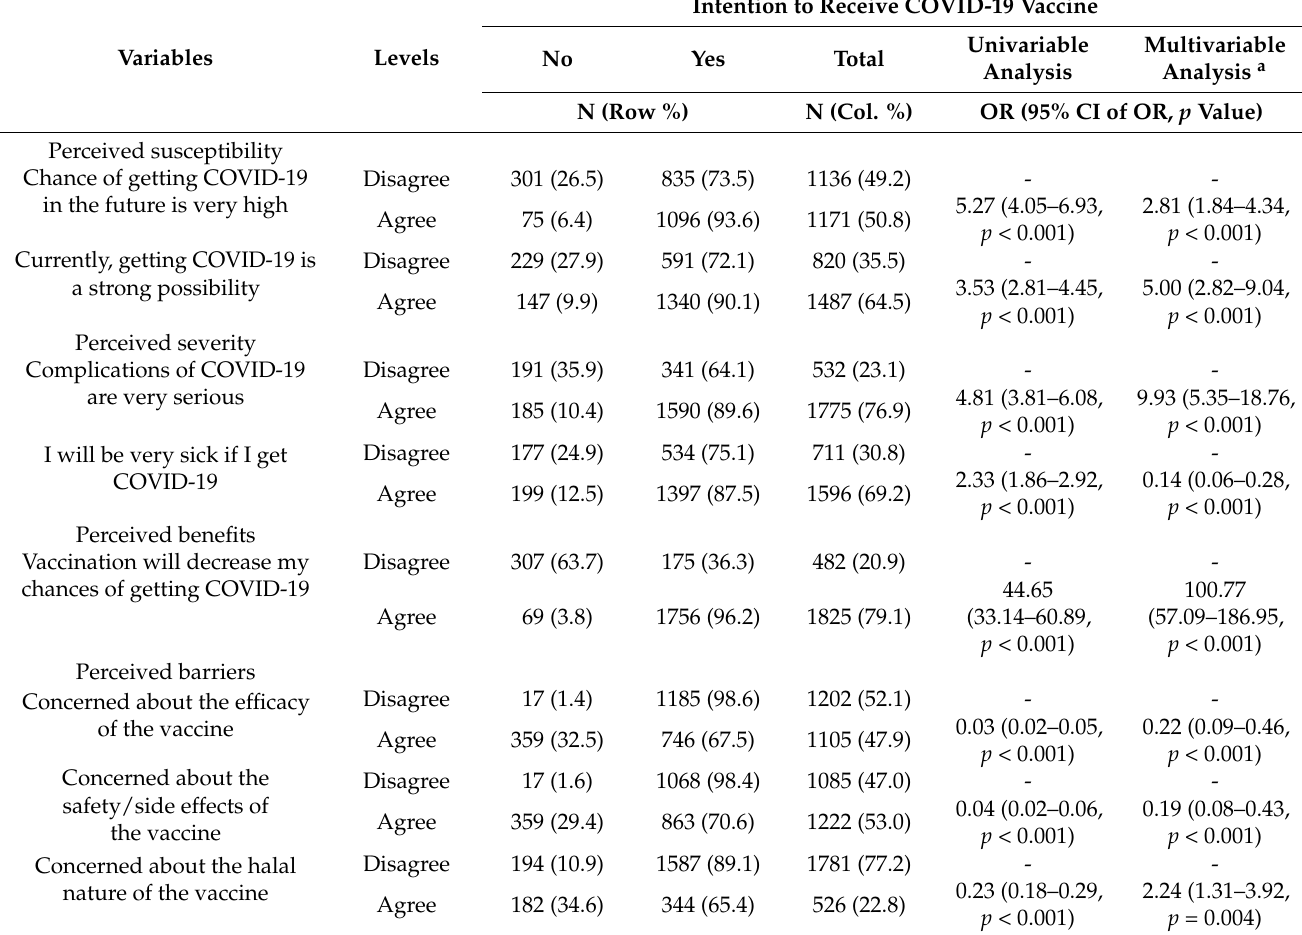
Table 2. Health belief model predictors of a positive intention to receive a COVID-19 vaccine in